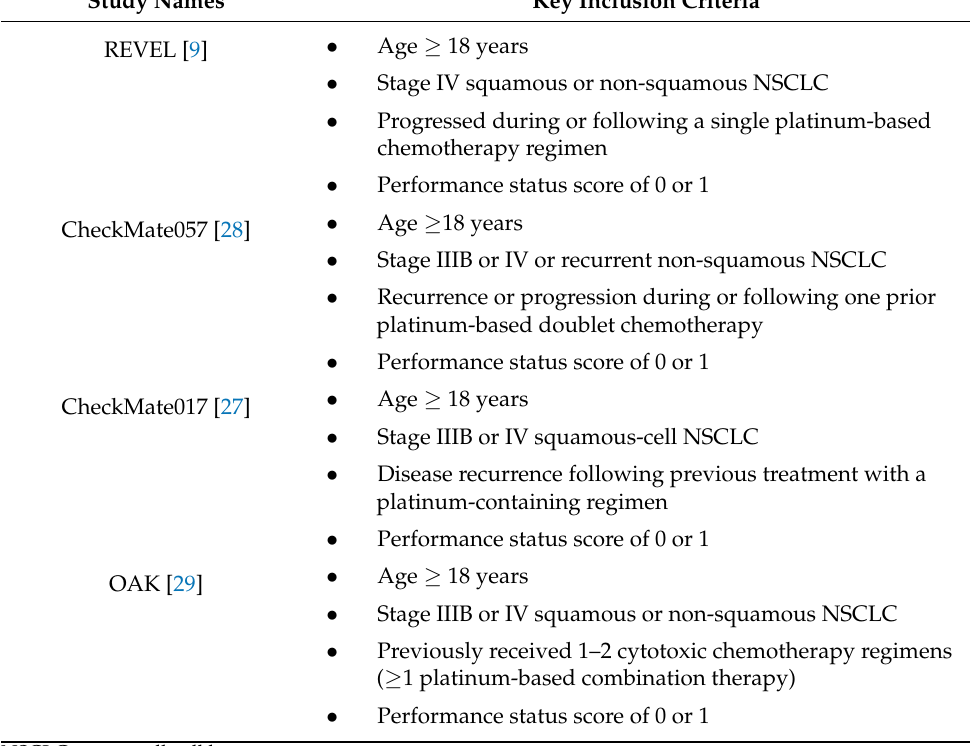
Figure 1. Study selection process. Table 1. Key criteria for study Table 1. Key criteria for study inclusion.